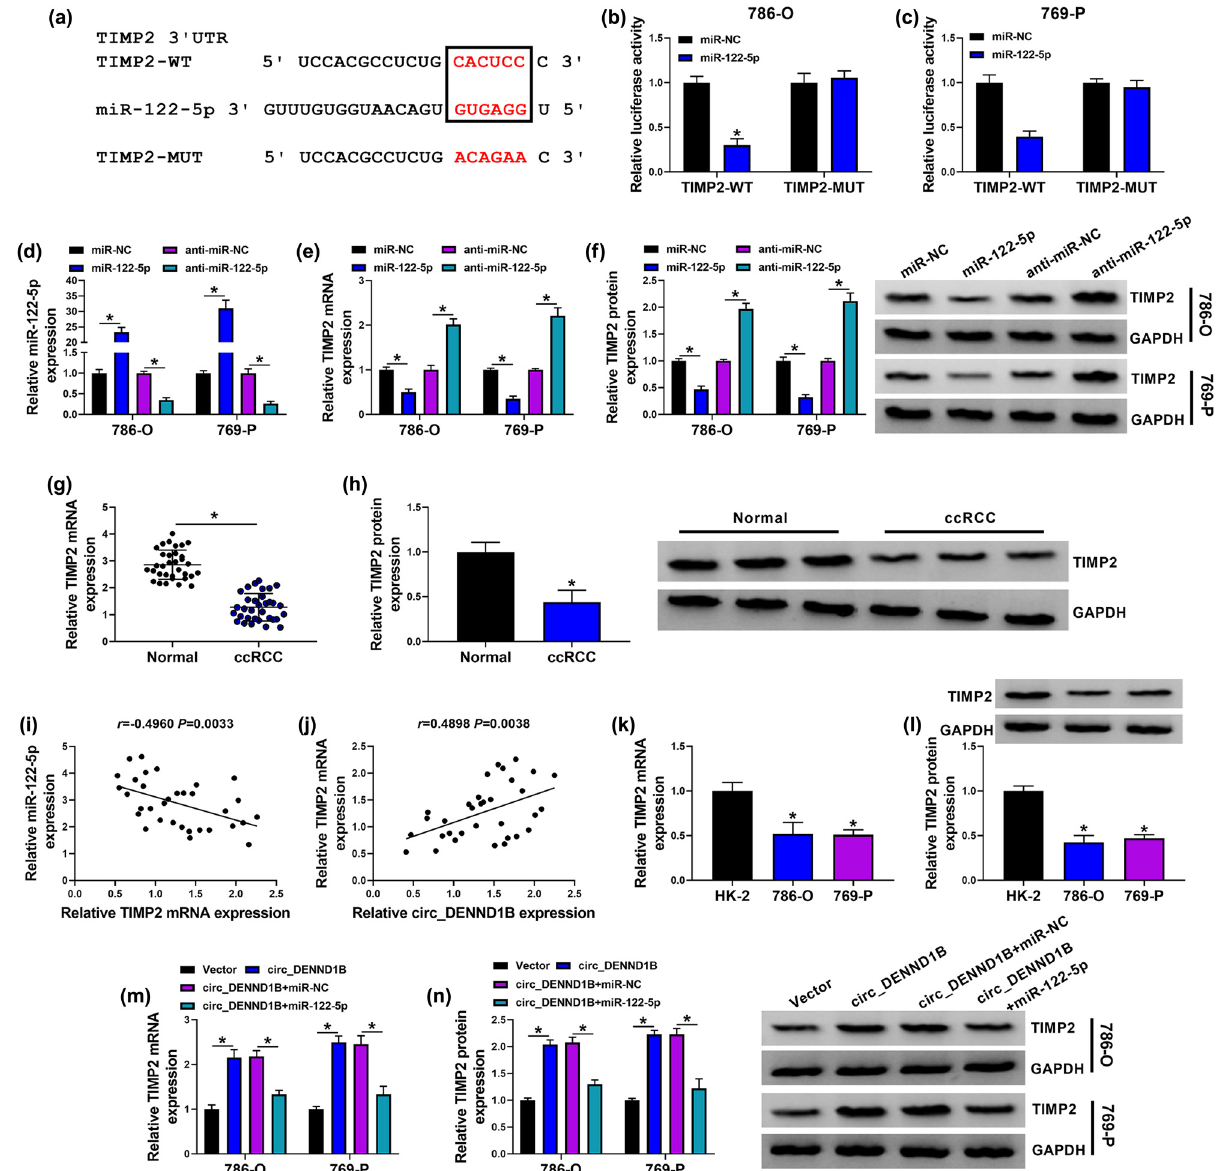
Figure 5: TIMP2 was a target of miR - 122 - 5p. ( a ) The binding sites of miR - 122 - 5p and TIMP2. ( b and c ) Dual - luciferase reporter assays were performed to con fi rm the association between TIMP2 and miR - 122 - 5p. ( d, e, g, k and m ) qRT - PCR detected the expression of miR - 122 - 5p and TIMP2. ( f, h, l and n ) Western blot detected the expression of TIMP2 protein. ( i and j ) Pearson ’ s correlation analysis. * P <